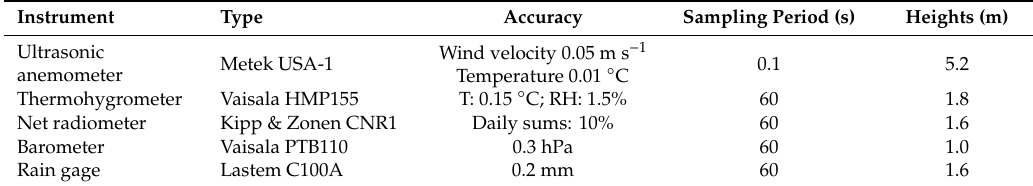
Table 1. Technical characteristics of the meteorological